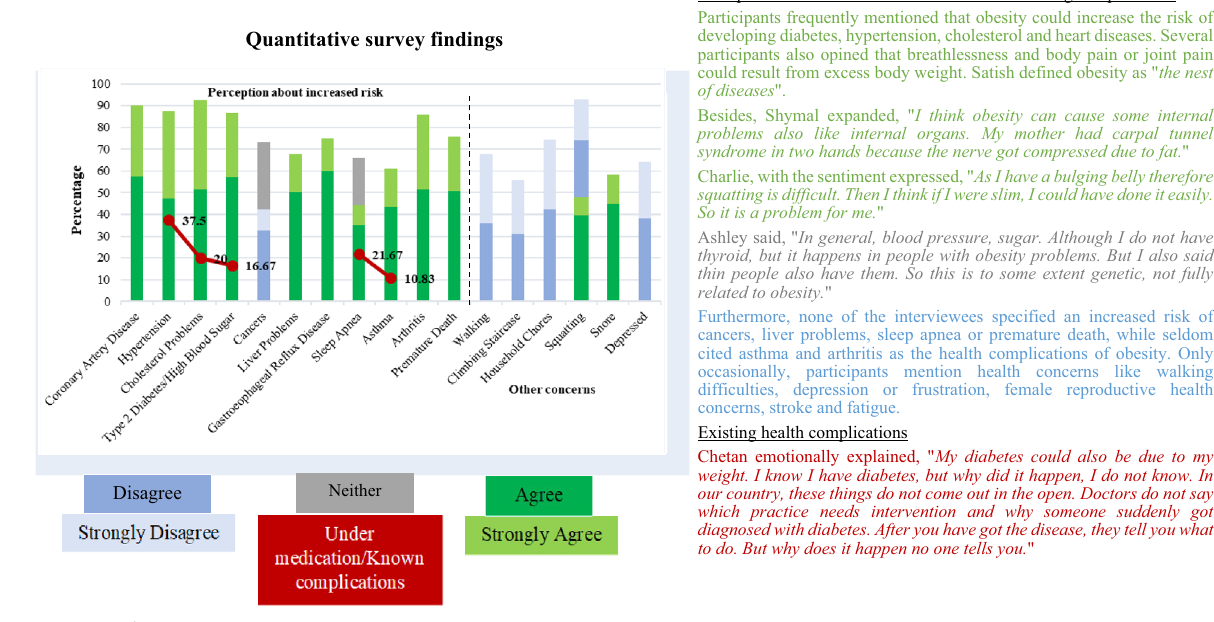
Table 4. Juxtaposed findings of quantitative and qualitative investigation on health complications.